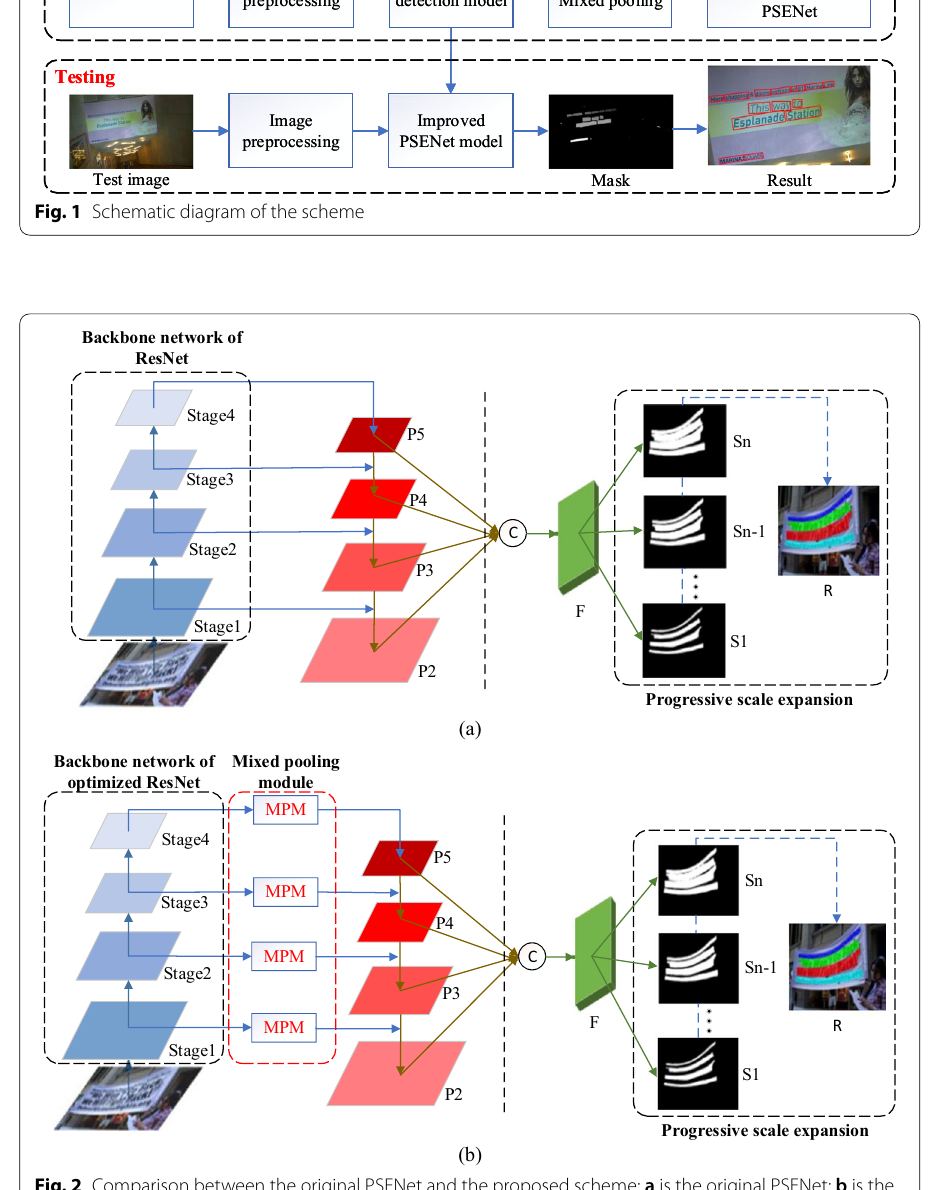
Fig. 2 Comparison between the original PSENet and the proposed scheme: a is the original PSENet; b is the proposed